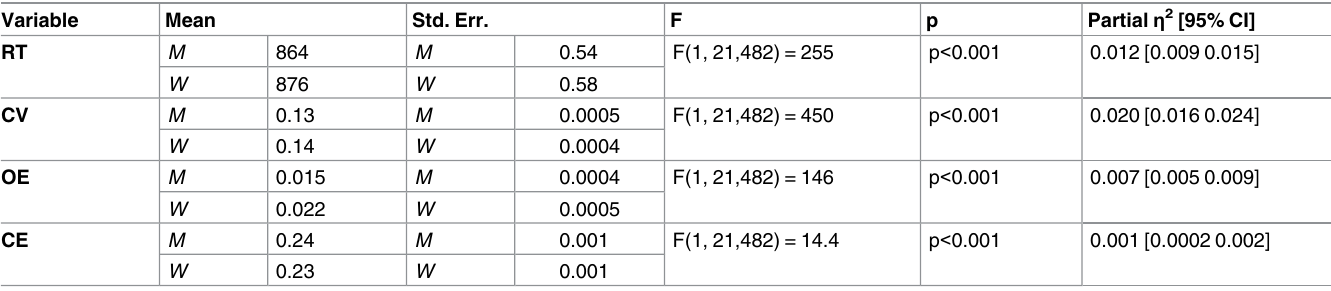
Table 1. Effects of gender on each of the four gradCPT variables. Variable Mean Std.